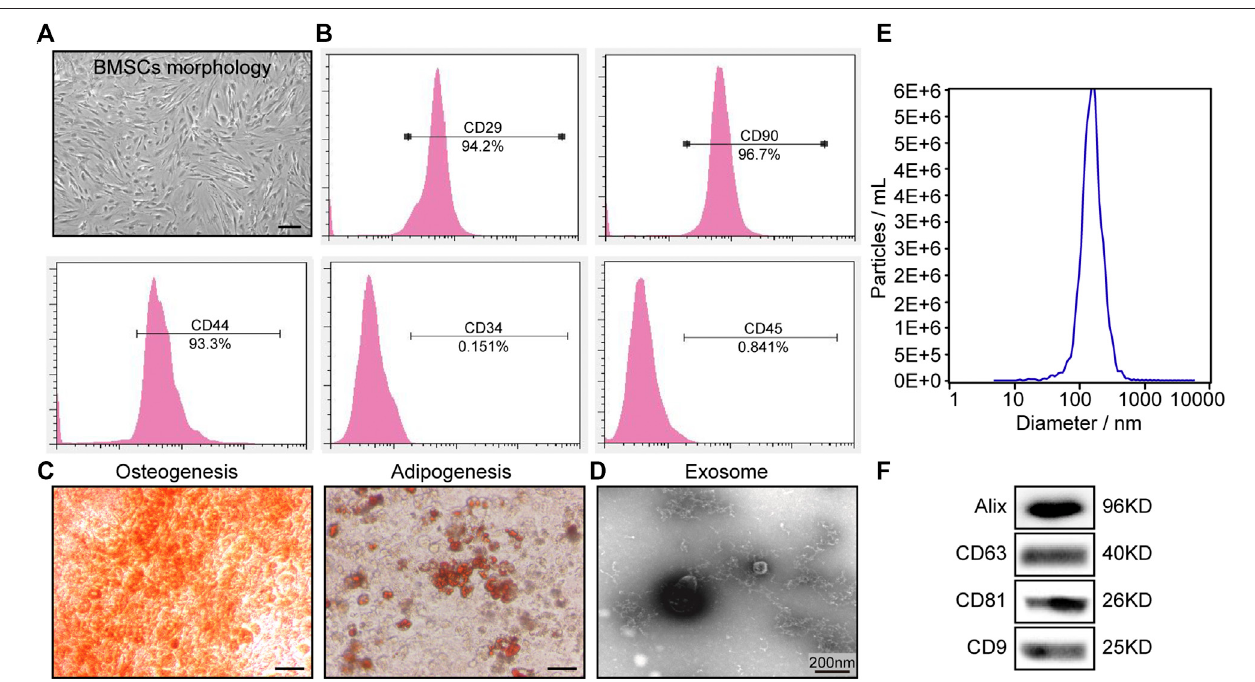
FIGURE1| BMSCand BMSC-exo characterization. (A) Representative images ofBMSCsfollowing culture for three passages. (B) AssessmentofBMSC staining for CD29, CD34, CD44, CD45, and CD90 via fl ow cytometry. (C) Representative images of BMSCs following osteogenic or adipogenic differentiation. Scale bar